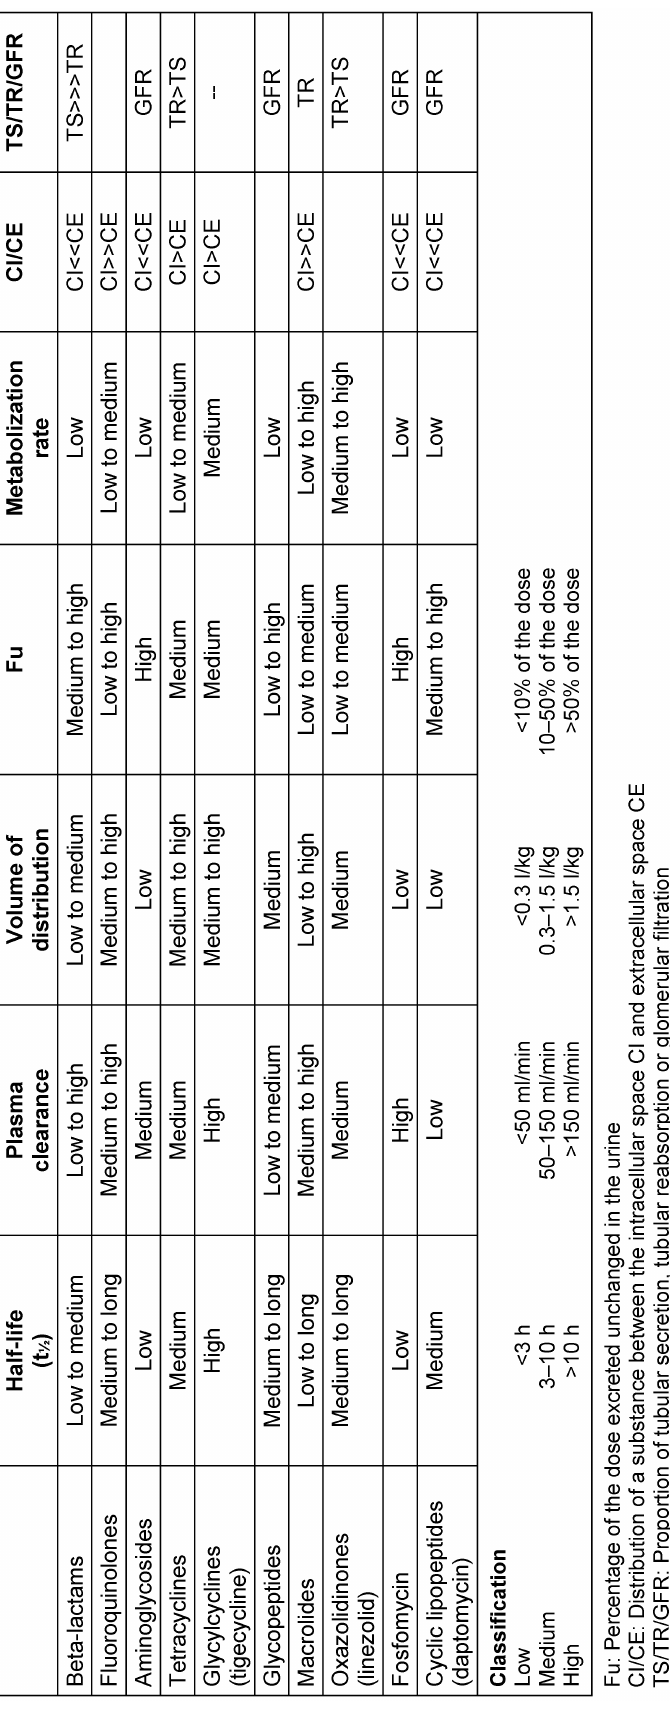
Table 1: Pharmacokinetic characteristics of parenteral